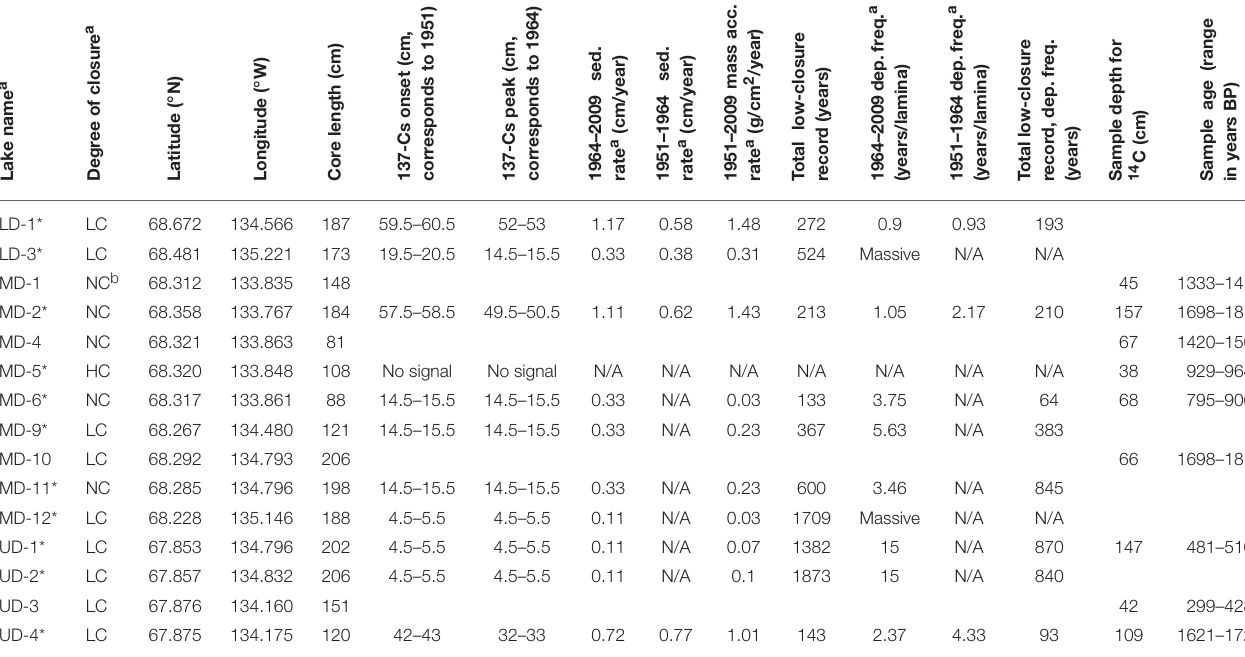
TABLE 1 | Descriptions of 15 cores in the Mackenzie River